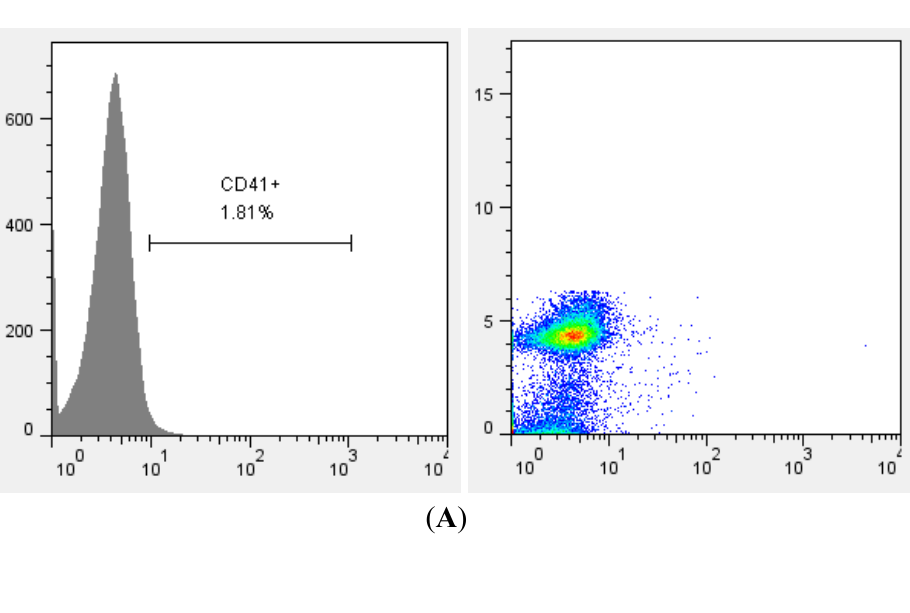
Figure 5. Flow cytometric analysis of HEL cells stained with anti-CD41-PE. Histogram plot (left panel) and dot plot (right panel) show the percentage of CD41 + cells. Data represent one experiment of two independent experiments. ( A ) Control